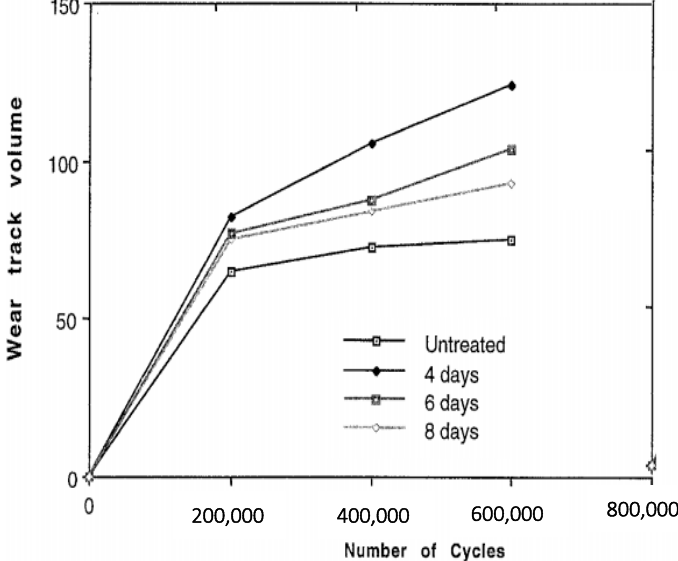
Figure 3. Change in wear volume under sliding tests for unaged and aged specimens. Reprinted with permission from [86].